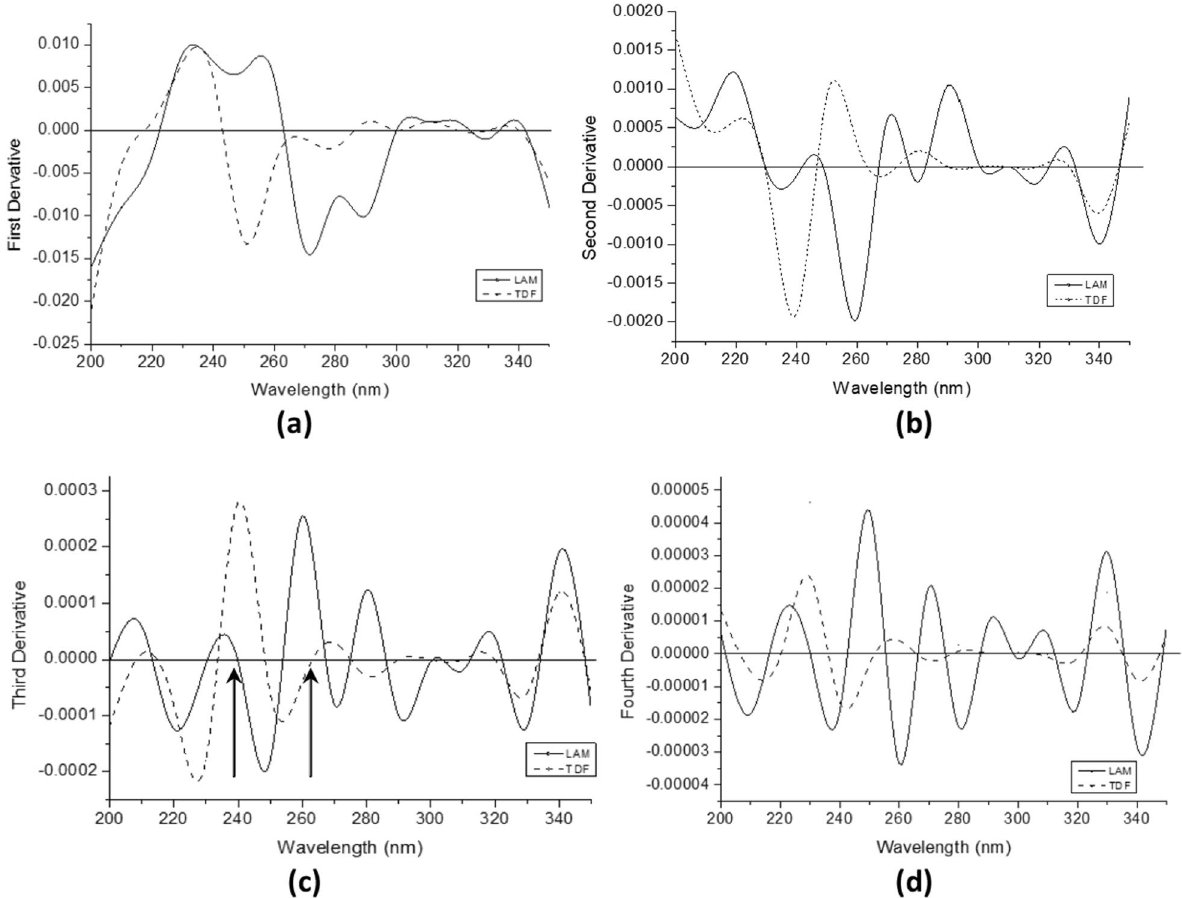
Fig. 3 Overlay spectra of a first (d A /d λ )-, b second (d 2 A /d λ 2 )-, c third (d 3 A /d λ 3 )- and d fourth (d 4 A /d λ 4 )-order derivatives of TDF and